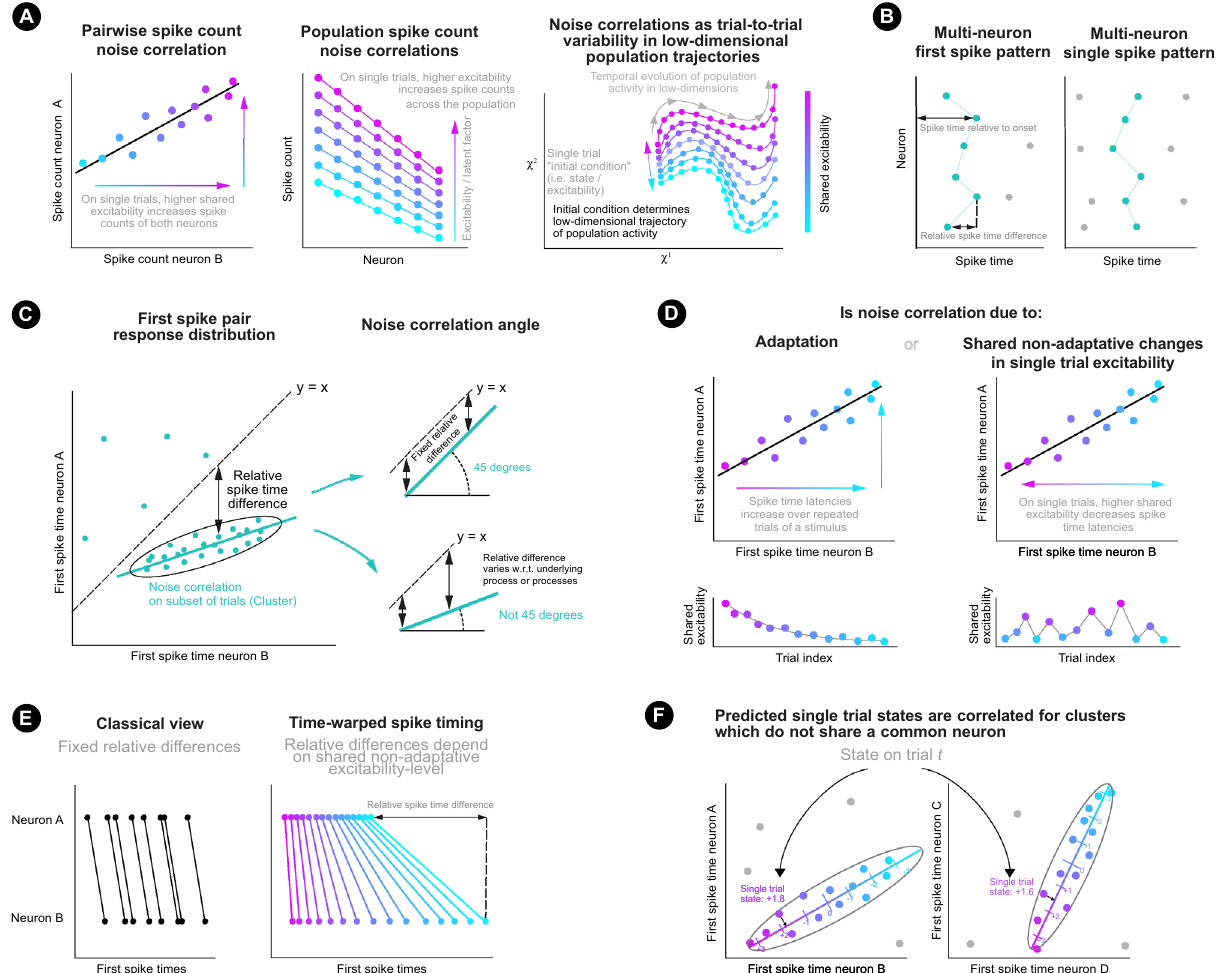
Figure 1. Explanatory figures. ( a ) Illustration of shared spike count variability over repeated trials of a condition for a neuron pair (left), for a population (centre) and exhibited as alternative single trial trajectories through low-dimensional space (right). ( b ) Illustration of multi-neuron first spike patterns (left) and single spike patterns (right). ( c ) Left: Illustrative (artificial) first spike stimulus-response distribution for two neurons and a single stimulus condition. Each point represents the first spike times of the two neurons on a trial on which both neurons spiked. A spike time noise correlation is observable within the isolated cluster. The vertical distance from a point to the line y = x represents the relative spike time difference for the first spike pair. Right: If the ◦ angle of the noise correlation is 45 , the relative spike time difference remains fixed (with random noise) w.r.t. ◦ the latent process/processes underlying the correlation. If the angle is different from 45 , the relative spike time difference varies w.r.t. the process/processes. ( d ) The latent process underlying the noise correlation may be due to adaptative (left) and/or non-adaptative (right) changes in the shared excitability-level of the two neurons from trial-to-trial. ( e ) Fixed relative spike time differences vs time-warped spike time differences. For the latter, the relative spike time difference is dependent on the non-adaptative single trial shared excitability-level. ( f ) Illustration of correlated predicted cortical state for disjoint pairs of